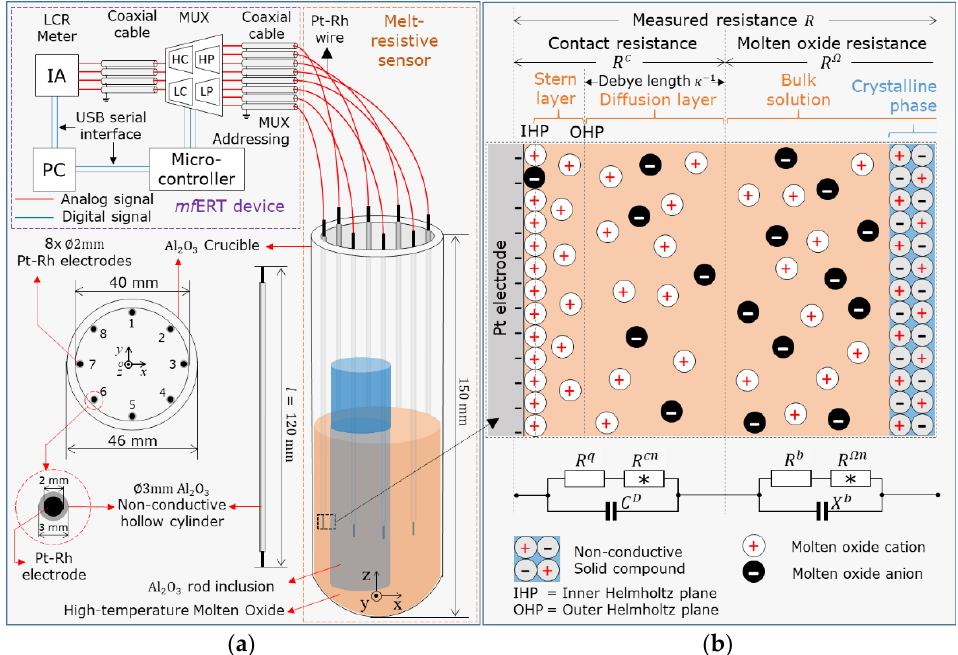
Figure 1. Schematic view of ( a ) the overall on-line mf ERT device and ( b ) the resistance measurement of molten oxide. of molten